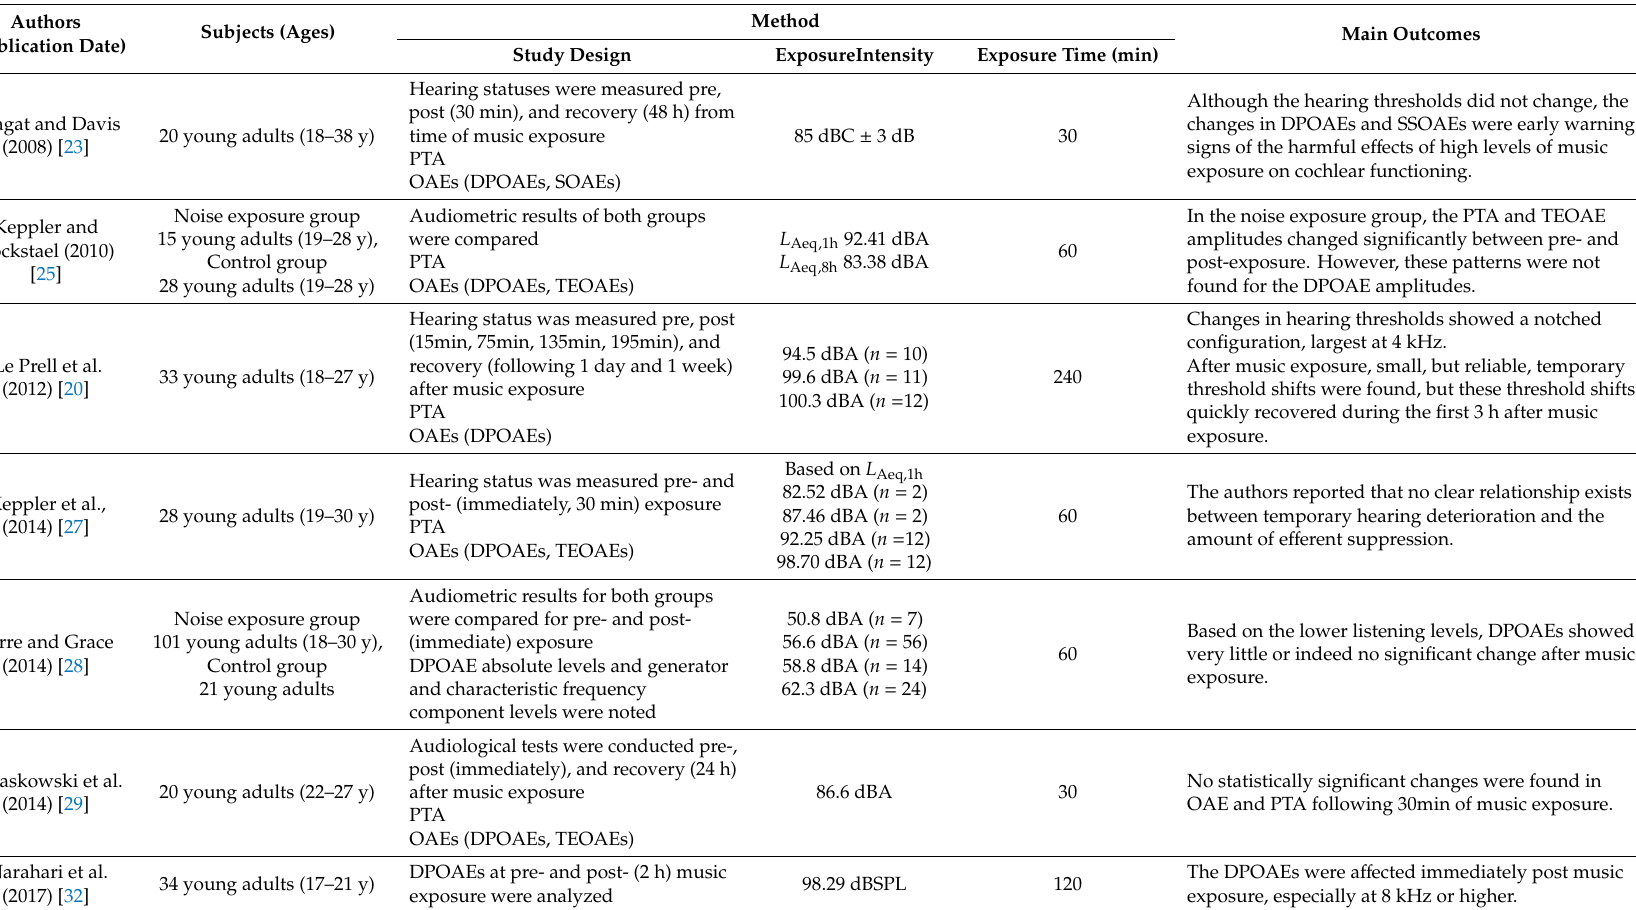
Table 3. Summary of studies showing short-term hearing changes and included in the